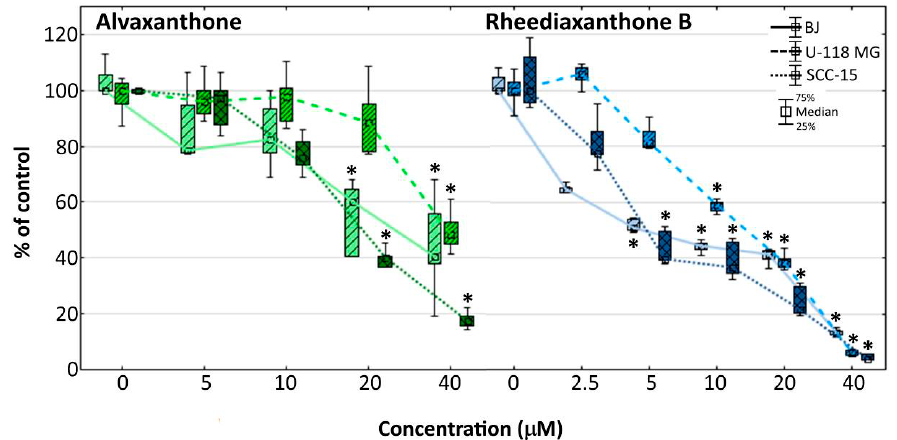
Figure 3. Influence of alvaxanthone or rheediaxanthone B on BJ, U-118 MG, and SCC-15 cells adhesion after 48-h treatment. The crystal violet assay was used. Results are medians of triplicate assays of three independent experiments expressed as a % of non-treated controls. The whiskers are lower (25%) and upper (75%) quartile ranges. * p ≤ 0.05, Kruskal–Wallis test (against non-treated control).